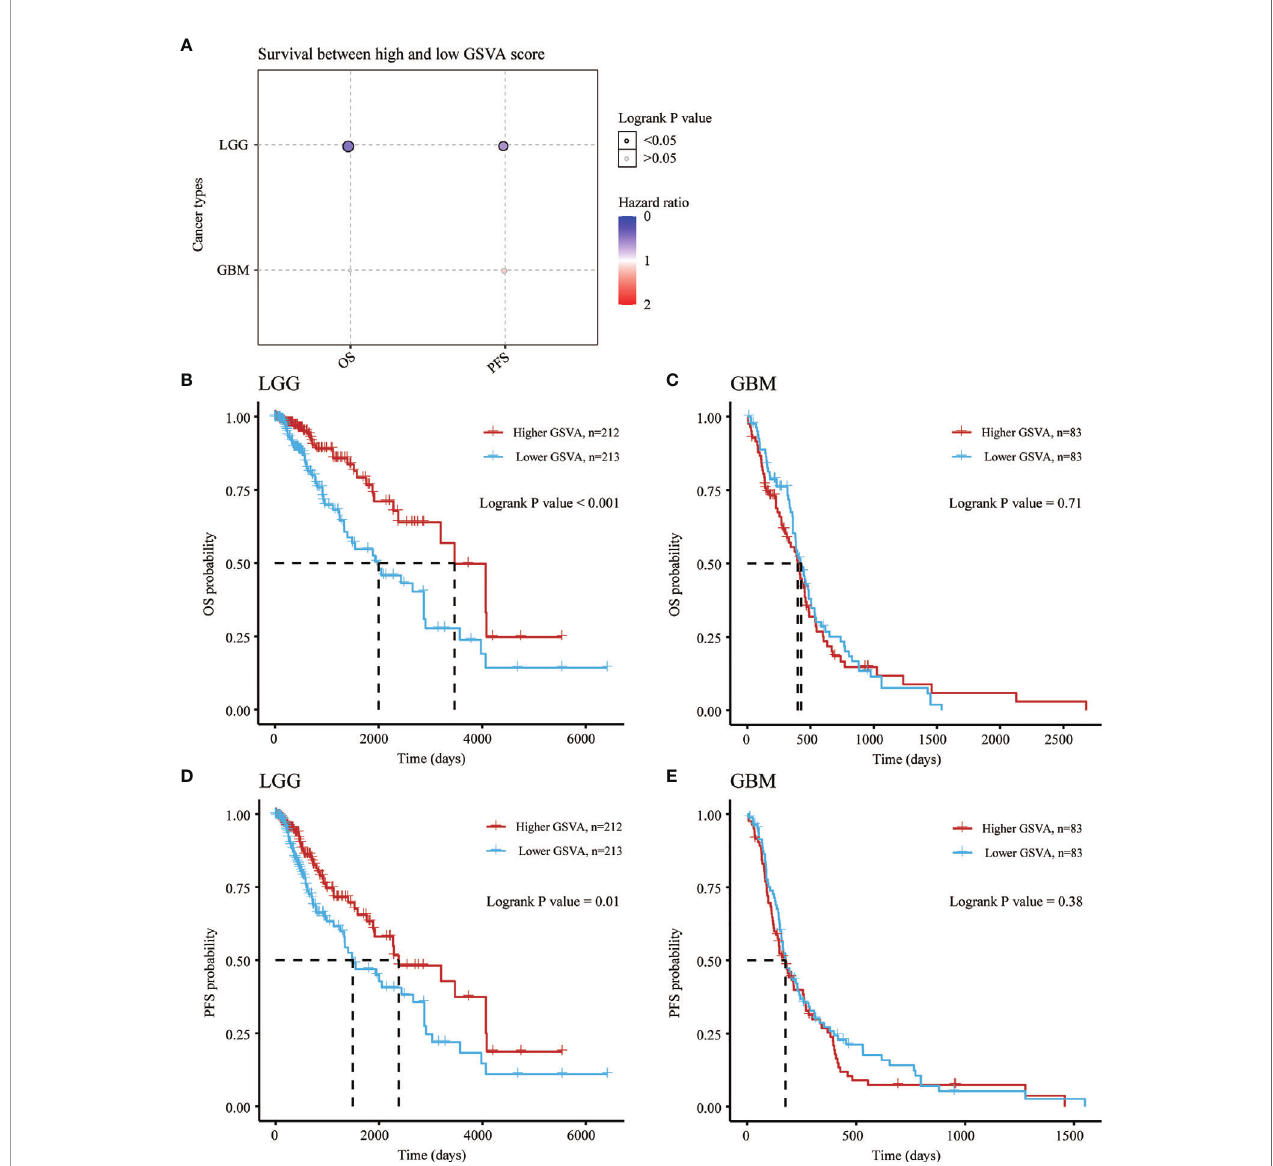
FIGURE 10 | Gene Set Variation Analysis of NRGs in LGG and GBM. Survival between high and low GSVA score in both LGG and GBM (A) . OS probability analysis for high and low GSVA scores of NRG1-4 in LGG (B) and GBM (C) . PFS probability analysis for high and low GSVA scores of NRG1-4 in LGG (D) and GBM (E)